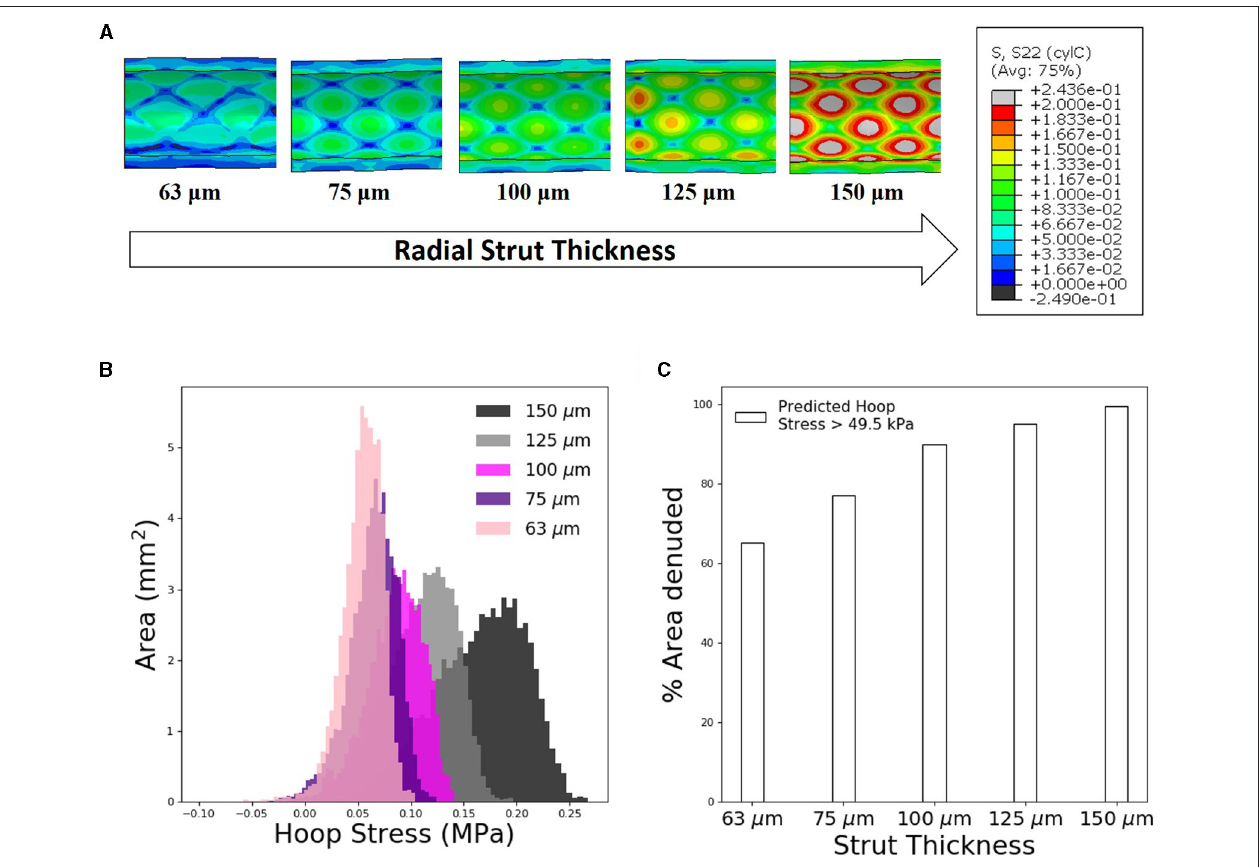
FIGURE 4 | Increasing stent strut thickness increases predicted arterial interstrut hoop stress and corresponding risk of endothelial denudation. (A) Arterial hoop stress (MPa) contour plots following deployment of slotted tube design for a range of radial strut thicknesses: 63, 75, 100, 125, and 150 µ m. (B) Distribution of arterial luminal surface area at given levels of hoop stress for each of the five stent strut thicknesses simulated. (C) Finite element analysis (FEA) predicted surface area exposed to an arterial hoop stress exceeding 49.5 kPa following deployment of each slotted tube design for varying radial strut